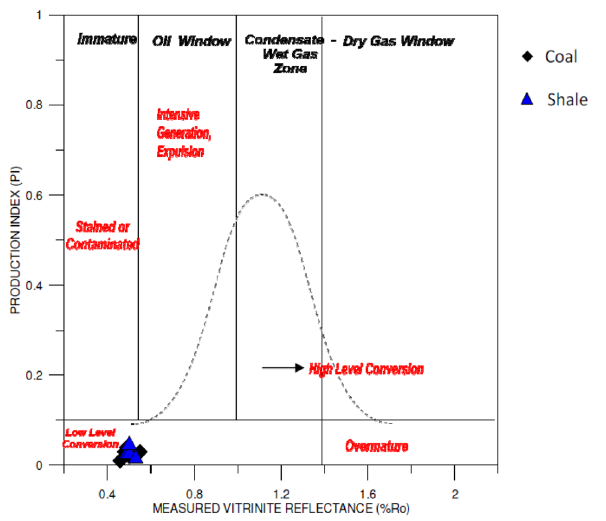
Fig. 12 Plot of production index (PI) against vitrinite reflectance of coal and shale samples from Maiganga, Gongola Basin. All the sam- ples are immature and have low level conversion of kerogen to